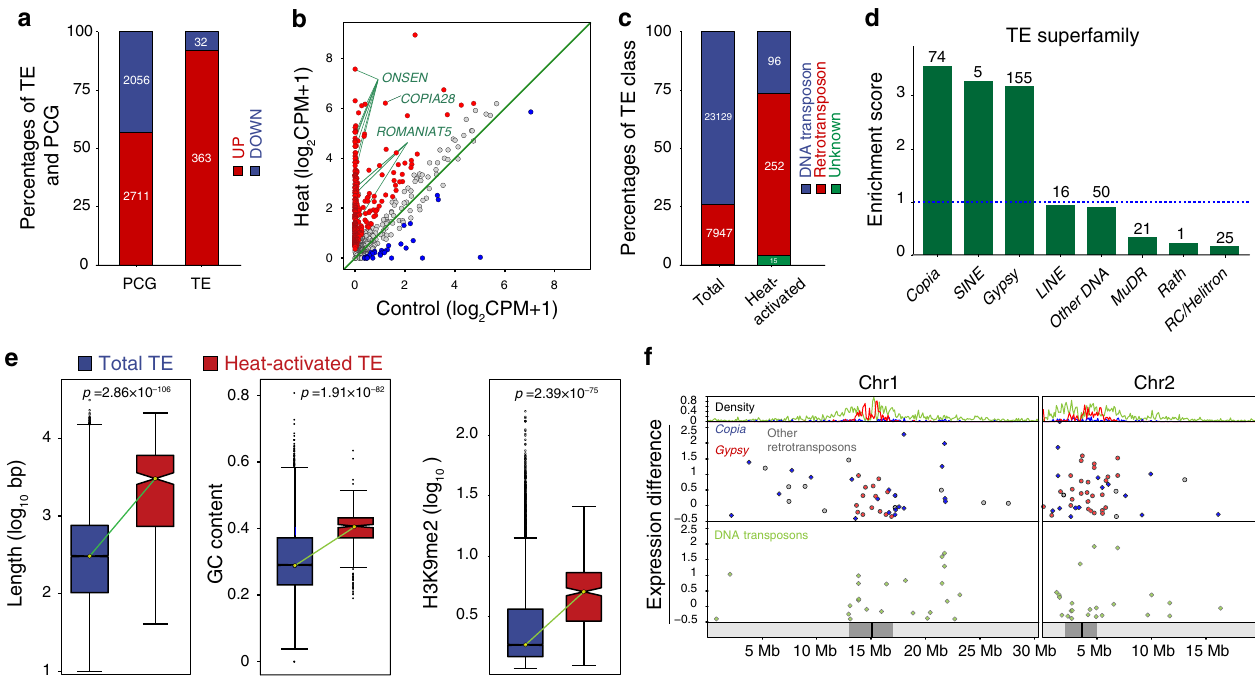
Fig. 1 Heat induces TE activation. a Percentages of up- and downregulated protein coding genes (PCGs) and transposable elements (TEs) under heat stress. Red bars: upregulation; Blue bars: downregulation. Numbers on the bars indicate the absolute number of TEs and PCGs. b Scatter plot of TE CPMs in heat vs. control conditions. CPM counts per million. Red dots: upregulated TEs under heat stress. Blue dots: downregulated TEs under heat stress. c The percentages of DNA transposons and retrotransposons for all (total) and for heat-activated TEs. Numbers marked on the bars indicate the absolute numbers of heat-activated TEs and total TEs from different TE classes. d The enrichment scores of TE superfamilies of heat-activated TEs. Each enrichment score was calculated as the ratio of the percentage of a certain TE superfamily in heat-activated TEs to that in all TEs. Numbers above the bars indicate the absolute numbers of heat-activated TEs in the corresponding superfamily. The blue dotted line marks the point of overrepresentation (enrichment score >1). e The lengths, GC contents, and H3K9me2 levels of TEs. The differences between heat-activated TEs and total TEs in the Arabidopsis genome was compared by a two-sided Mann – Whitney U test for each feature. For each box plot, center lines indicate the medians; boxes show the 25th and 75th percentiles; whiskers extend to the minimum and maximum. f Chromosomal distributions of heat-activated TEs in chromosomes 1 and 2. The uppermost track shows the density of Copia (blue) and Gyspy (red) retrotransposon superfamilies and DNA transposons (green). The two tracks in the middle show the distribution of retrotransposons and DNA Transposons. Expression differences were calculated by log 10 (Heat CPM − Control CPM ). TEs belonging to the Copia and Gyspy retrotransposon superfamilies and DNA transposons are colored in blue, red, and green, respectively. Other retrotransposons are colored in gray. The bottom track shows the positions of centromeres (black) and pericentromeres